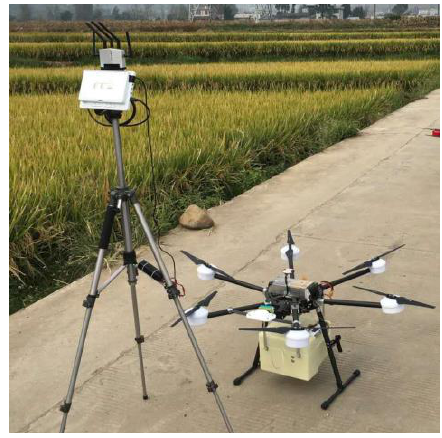
Figure 1. AOEagle is equipped on a UAV of six